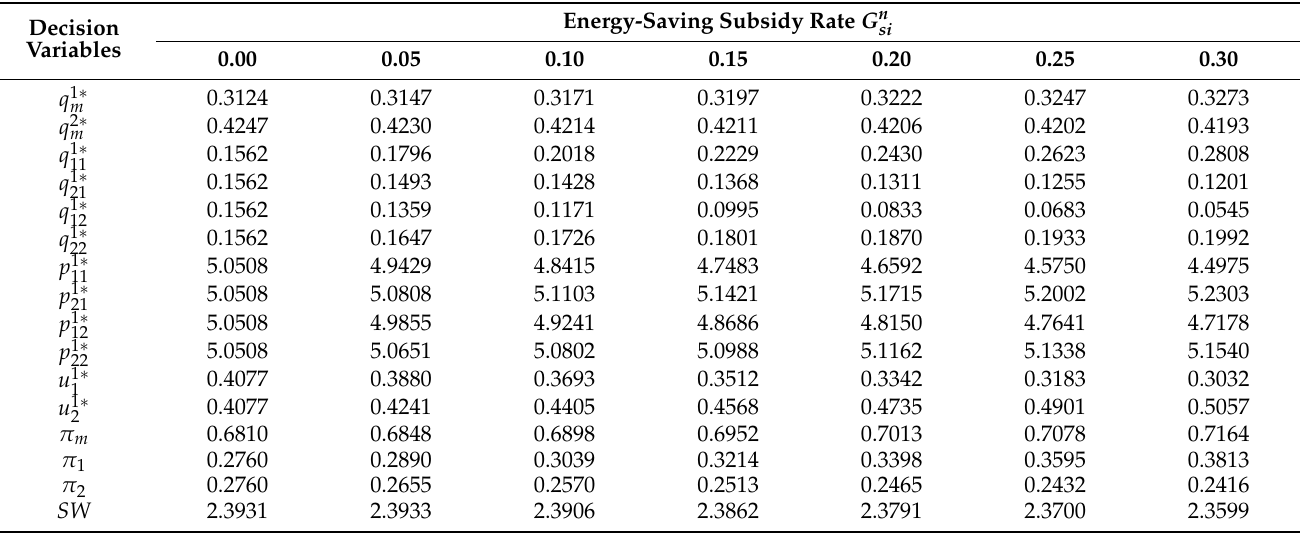
Table A2. The equilibrium result of government only subsidies to retailer 1 in market 1 when demand scale for HEEP and LEEP is